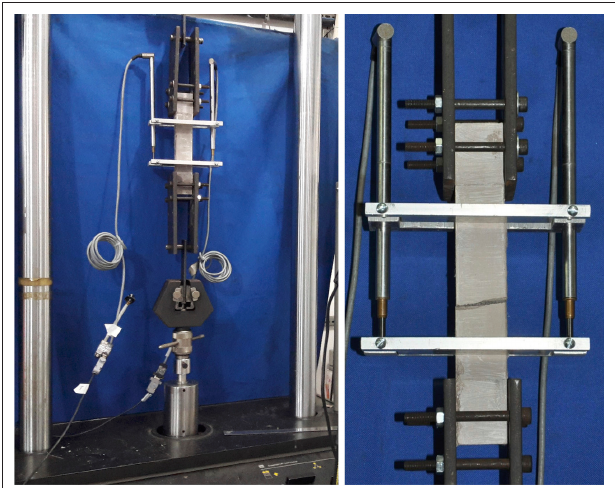
FIGURE 3 | Assembling the tensile strength test and fractured